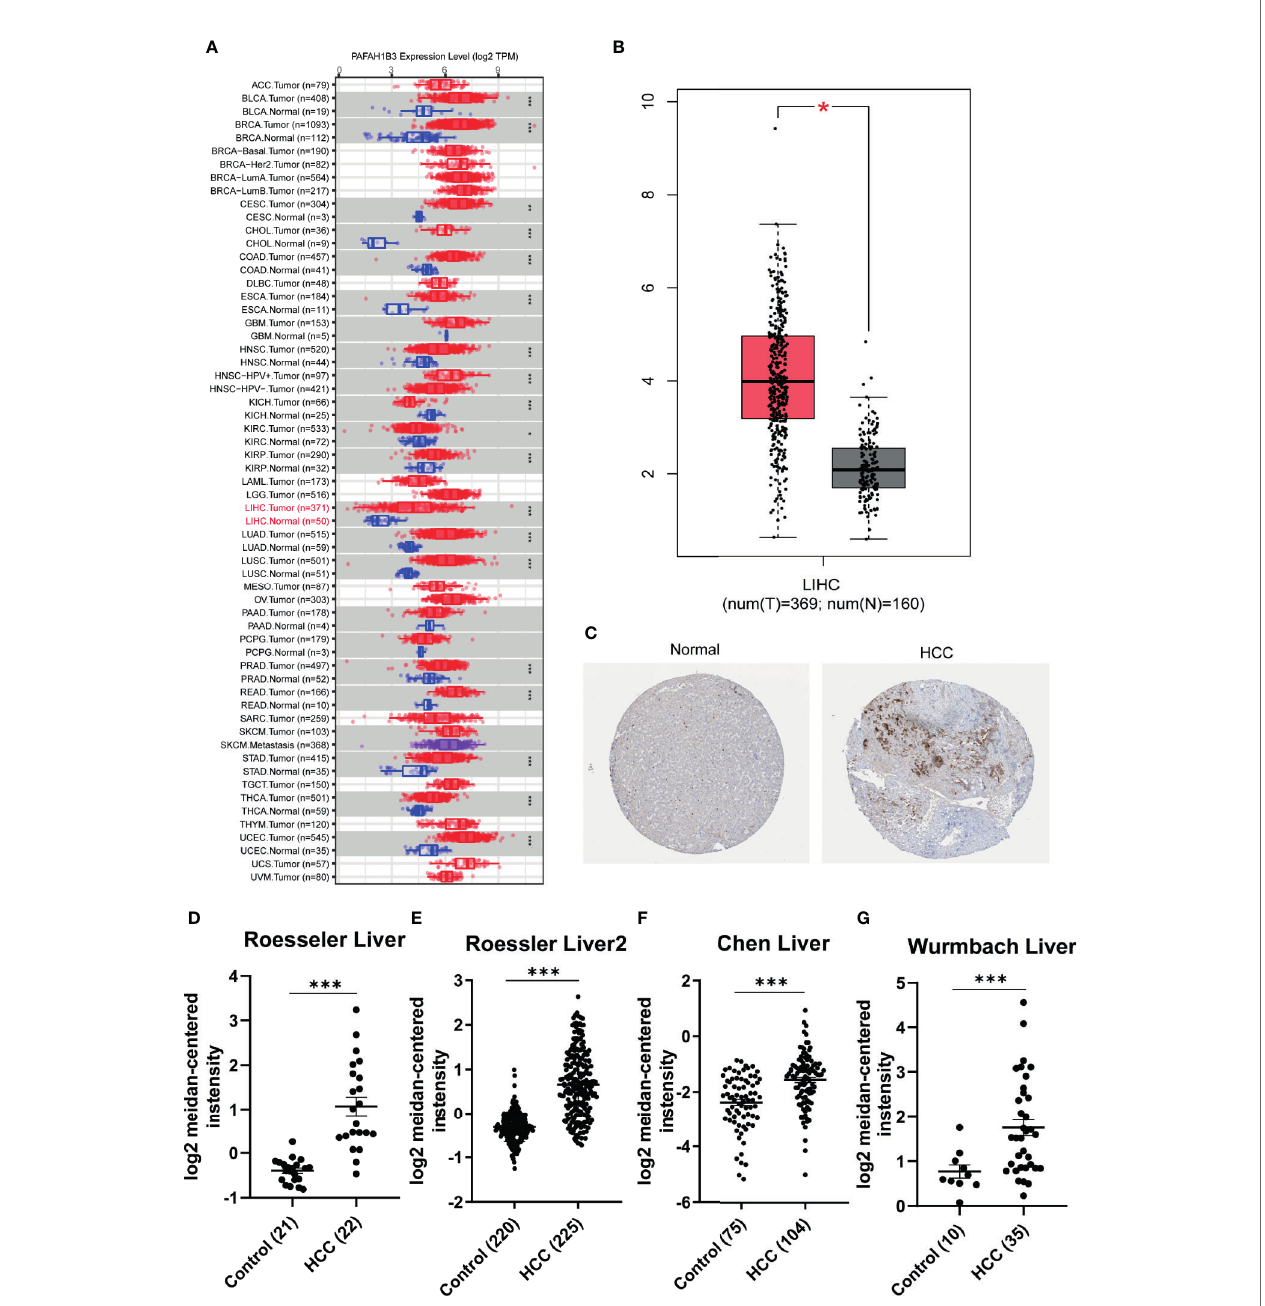
FIGURE 1 | Expression of PAFAH1B3 in hepatocellular carcinoma (HCC). (A) The transcription level of PAFAH1B3 in TIMER databases. (B) The transcription level of PAFAH1B3 in ONCOMINE databases. (C) The protein expression of PAFAH1B3 in LIHC (HPA). (D) Boxplot showing the levels of PAFAH1B3 mRNA in the Roessler Liver. (E) Boxplot showing the levels of PAFAH1B3 mRNA in the Roessler Liver 2 datasets. (F) Boxplot showing the levels of PAFAH1B3 mRNA in the Chen Liver datasets. (G) . Boxplot showing the levels of PAFAH1B3 mRNA in the Wurmbach Liver datasets. *p < 0.05; ***p <